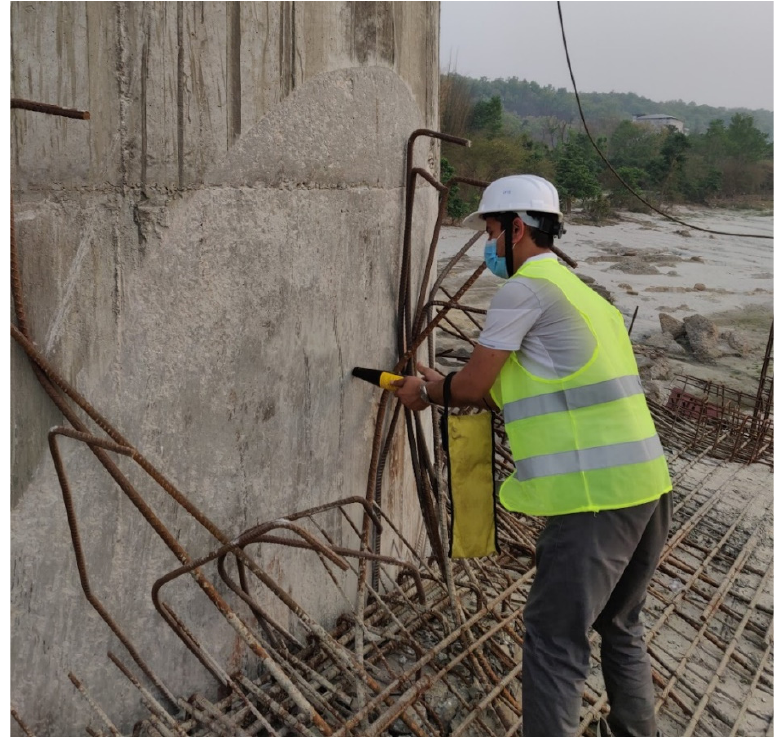
Figure 18. Damage to Pier-1 by end cross beam of Span-2 during collapse.